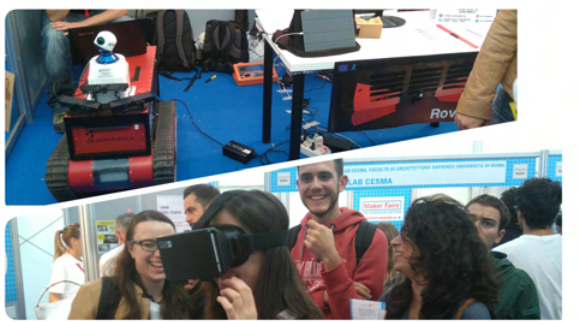
Figure 6. ROVINA VR Viewer prototype tested by visitors of the Maker Faire Rome